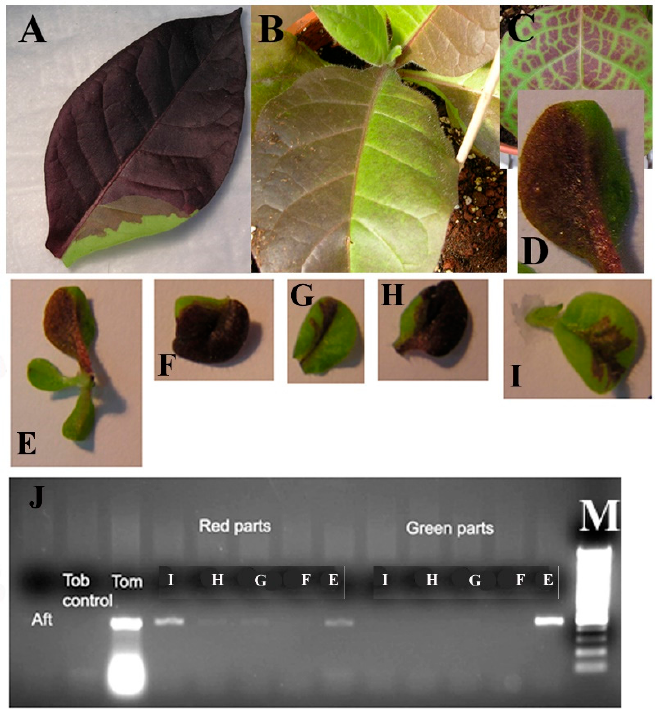
Figure 3. ( A – D ): Leaves of transformed tobacco show chimerism even on selection medium after transformation with tomato ScANT1 gene construct and selection on Kanamycin. ( E – I ) Pictures of tobacco leaves transformed with the ScANT1 construct. ( J ) PCR analysis of genomic DNA isolated from Red or Green sections of the leaves in ( E – I) .